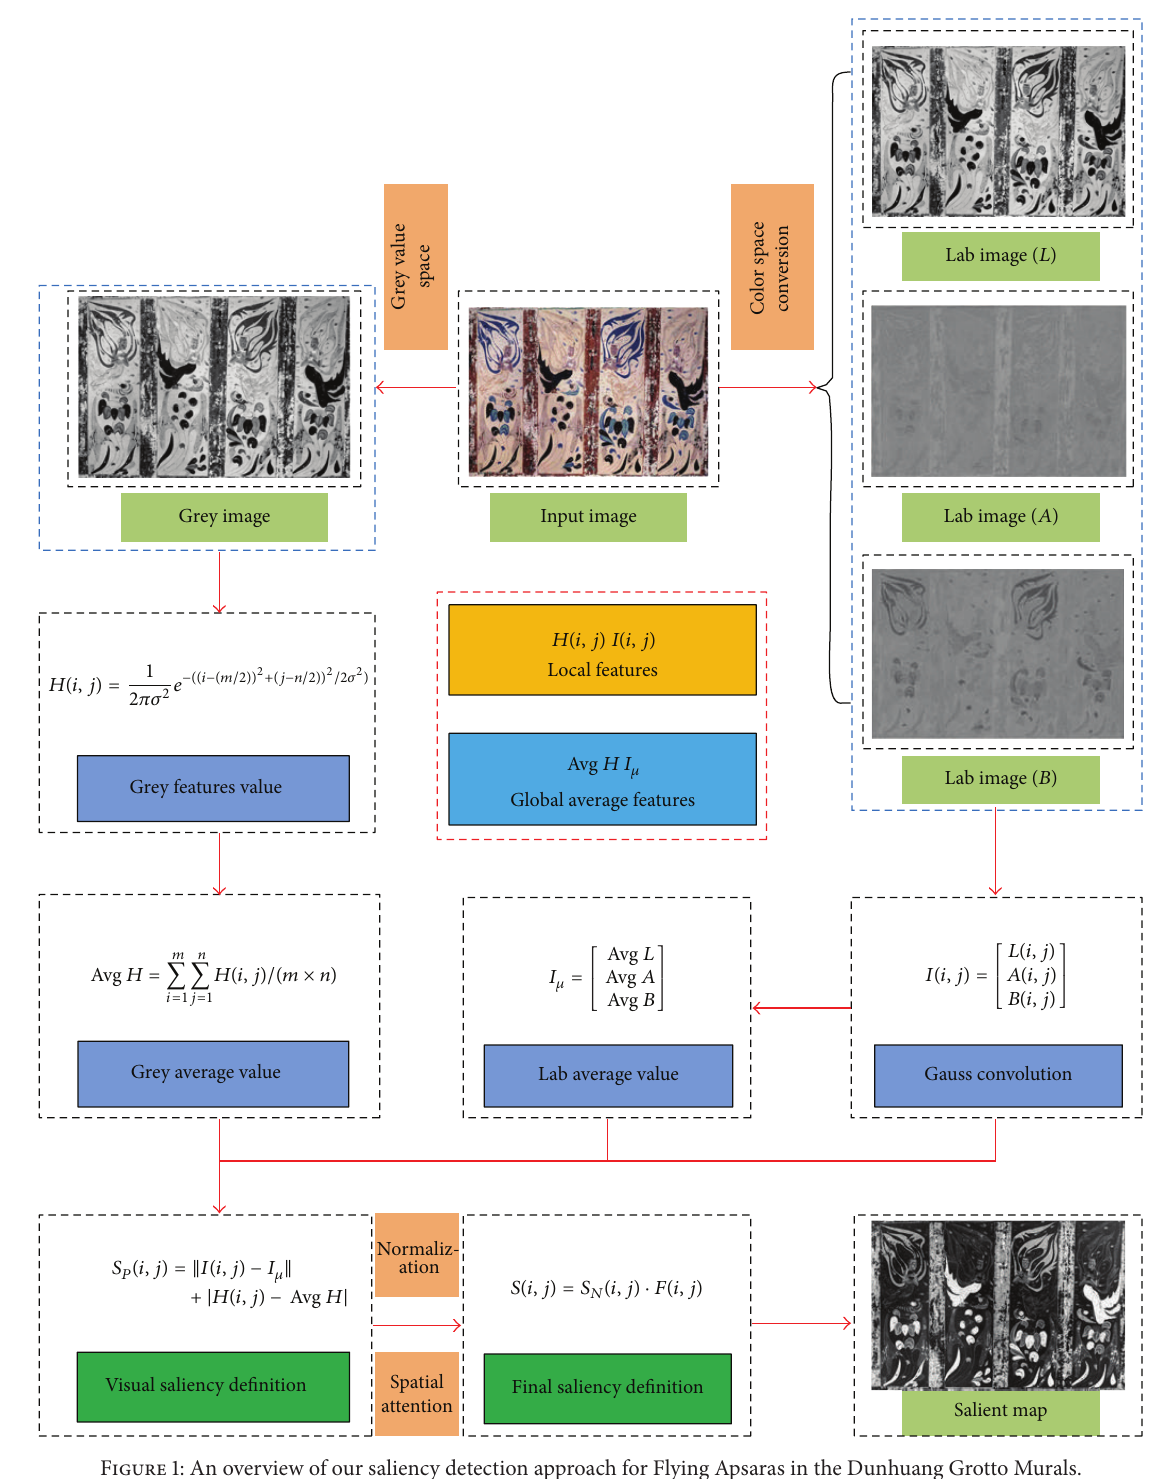
Figure 1: An overview of our saliency detection approach for Flying Apsaras in the Dunhuang Grotto Murals.